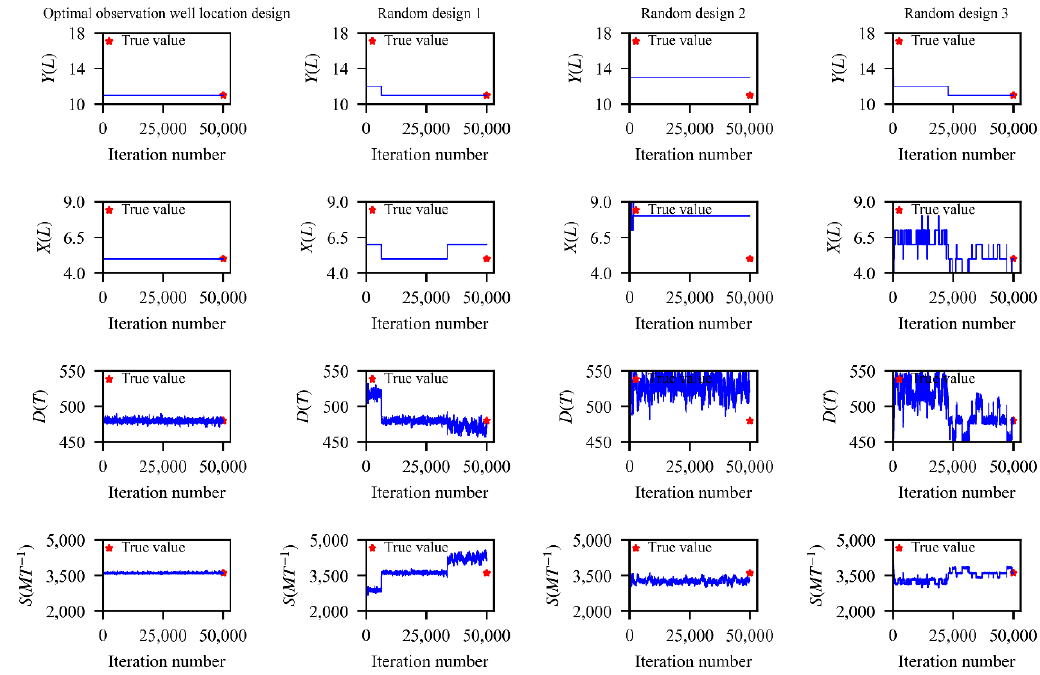
Figure 8. Trace plots of the MCMC simulation for Case 2.